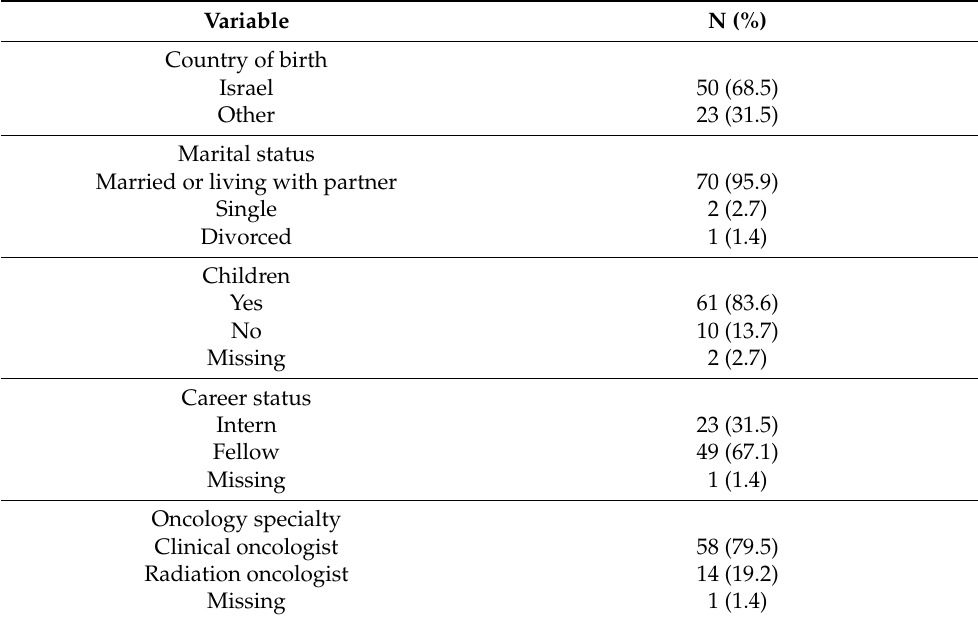
Table 1. Demographic and medical variables by